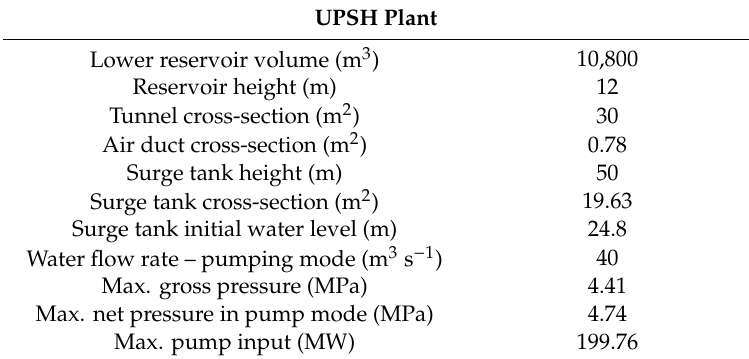
Table 1. Main geometrical parameters of UPSH model and pump-turbine